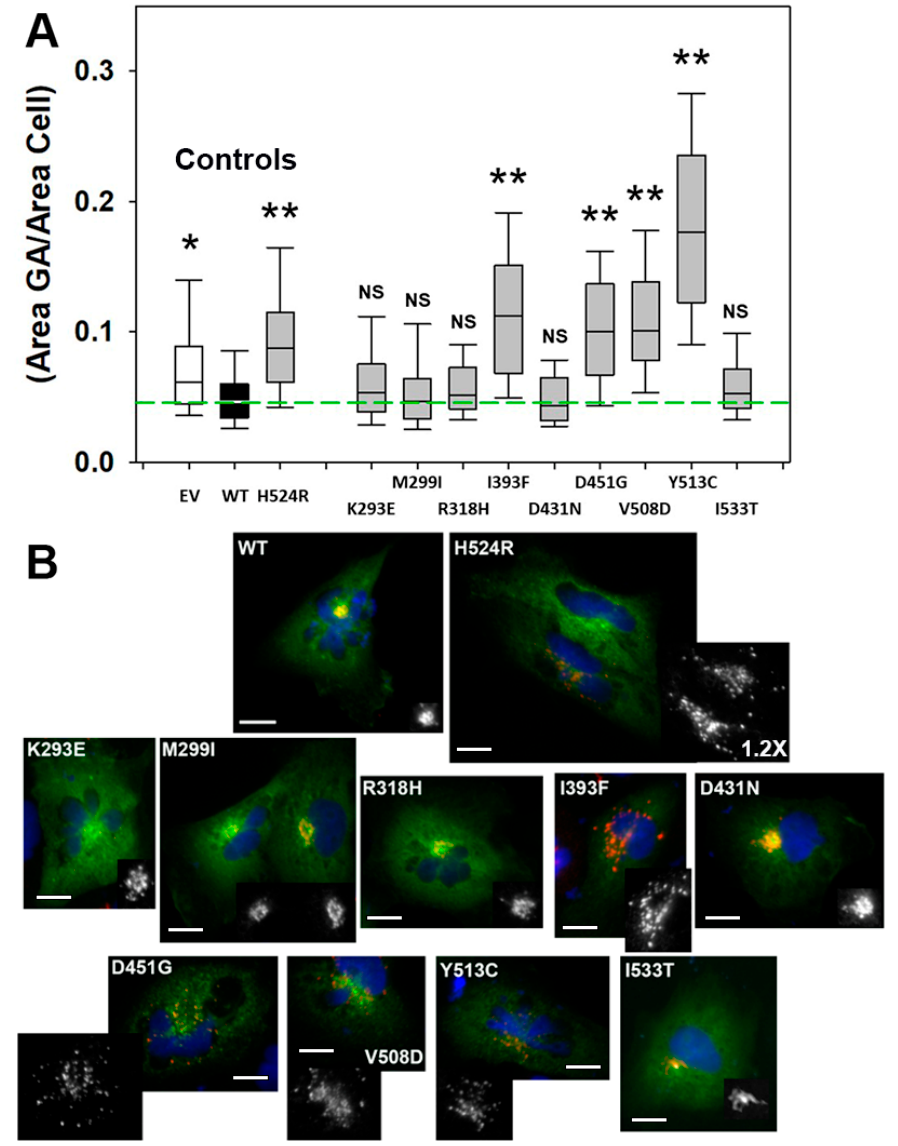
Figure 4. Golgi apparatus fragmentation phenotype induced by OCRL1 VAR . ( A ). Presence and magnitude of this phenotype was assessed by computing the ratio between the area occupied by the Golgi apparatus (GA) and that corresponding to the whole cell (see text for details). Plot depicts combined data from 3 experiments (see Figure 5 for a representative experiment showing individual cell variation). Green dashed line highlights median value obtained for cells expressing OCRL1 WT from a distribution with Q1 = 0.034, Q3 = 0.06; IQR = 0.026 (see Materials and Methods). EV: cells transfected with pEGFP empty vector. Statistical significance of the differences between the distributions of WT and variants was assessed using the Wilcoxon test with p < 0.05 applying Bonferroni’s correction for multiple comparisons to α B ≤ 0.005 (*) or α B ≤ 0.001 (**) per comparison NS: Not significant. ( B ) Representative images showing HK2 OCRL1 KO cells expressing GFP-OCRL1 WT or the indicated GFP-OCRL1 VAR (green signal) and immunostained for the GA marker TGN46 (red signal). The latter is also reproduced in black and white for clearer visualization. Scale bars: 15 µ m. When applicable, additional magnification is indicated (i.e., 1.2 ×